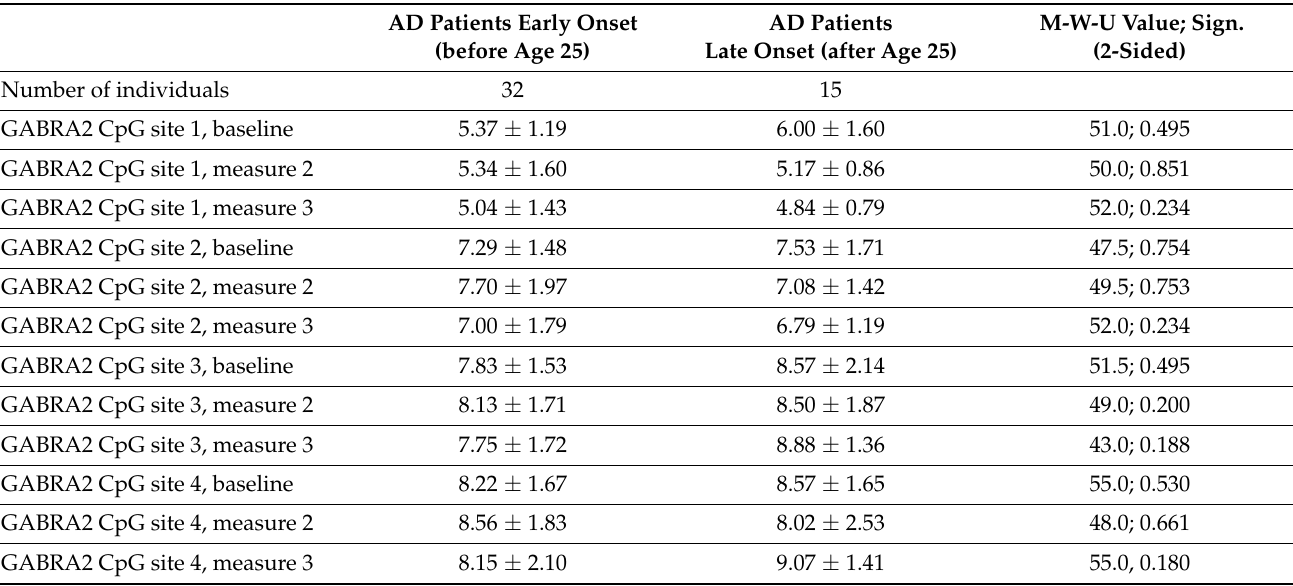
Table 5. Early vs. Late onset patients and GABRA2 CpG Site Methylation in Alcohol-Dependent Patients and